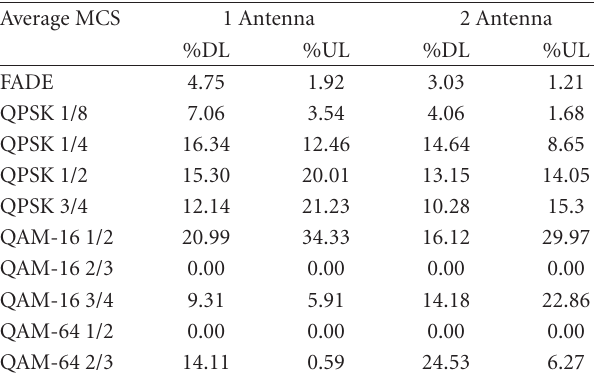
Table 13: Percent MCS for 1 × 1 and 2 × 2 antennas